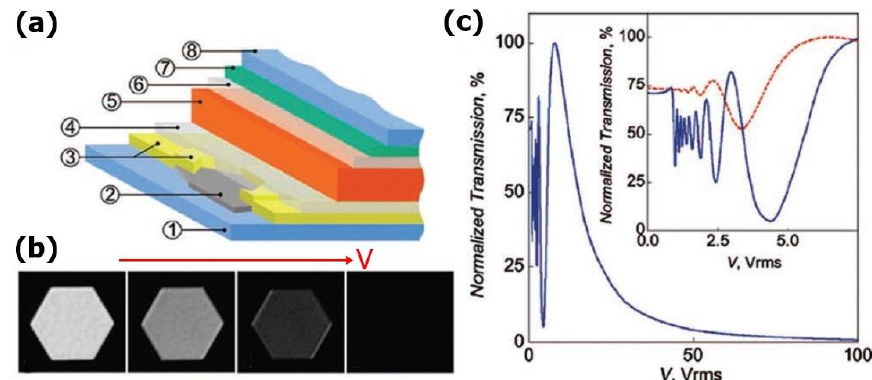
Figure 10. Liquid crystal sandwich cell made of a graphene layer electrode and an ITO electrode. ( a ) The cell is constructed of ① a glass substrate, ② a graphene layer, ③ electrical contacts, ④ an alignment layer, ⑤ the liquid crystal layer, ⑥ another alignment layer, ⑦ an ITO electrode, and ⑧ the top glass substrate. ( b ) Due to the positive dielectric anisotropy of the LC, the optic axis switches from planar to homeotropic; thus, it switches from bright to dark between crossed polarisers for increasing voltage. ( c ) Light transmission through the 20-μm thick LC device as a function of applied voltage. The inset depicts the low-voltage regime in more detail for monochromatic green light (505 nm, blue curve) and for white light (red curve). (Reproduced by permission from ref. [128]). The transmission through the 20 μm thick LC device is shown in Figure 10c for monochromatic green light with a wavelength of 505 nm (blue curve), as well as for white light (red curve in the inset). The oscillatory behaviour of the transmission is due to the change in birefringence, as the molecular long axis reorients for increasing applied voltage, which results in an additional phase retardation of several multiples of π.